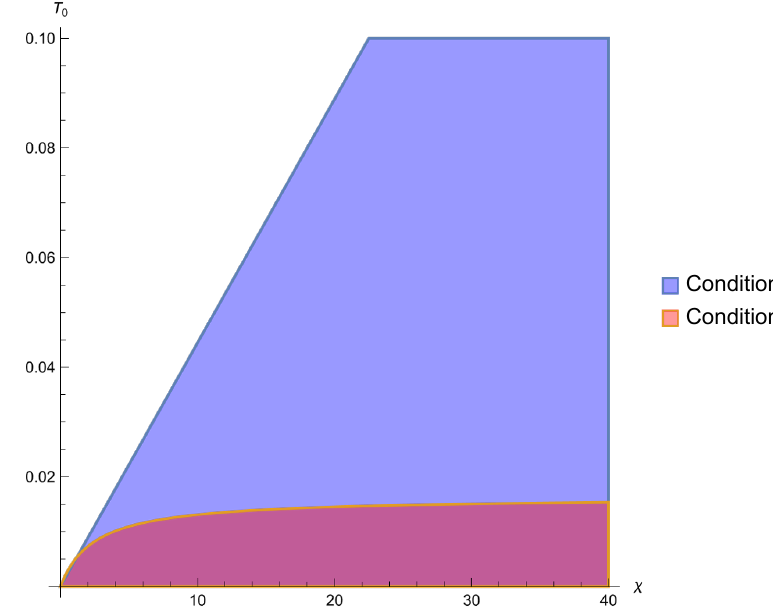
Figure 2 . A plot of T 0 vs χ for w = 2 / 3 , ρ 0 = 2 × 10 − 4 in natural units with the normalization a 0 set to 10. The conditions at a given χ are only satisfied for a small enough T 0 , but for any χ there is always such a T 0 for which the conditions are all